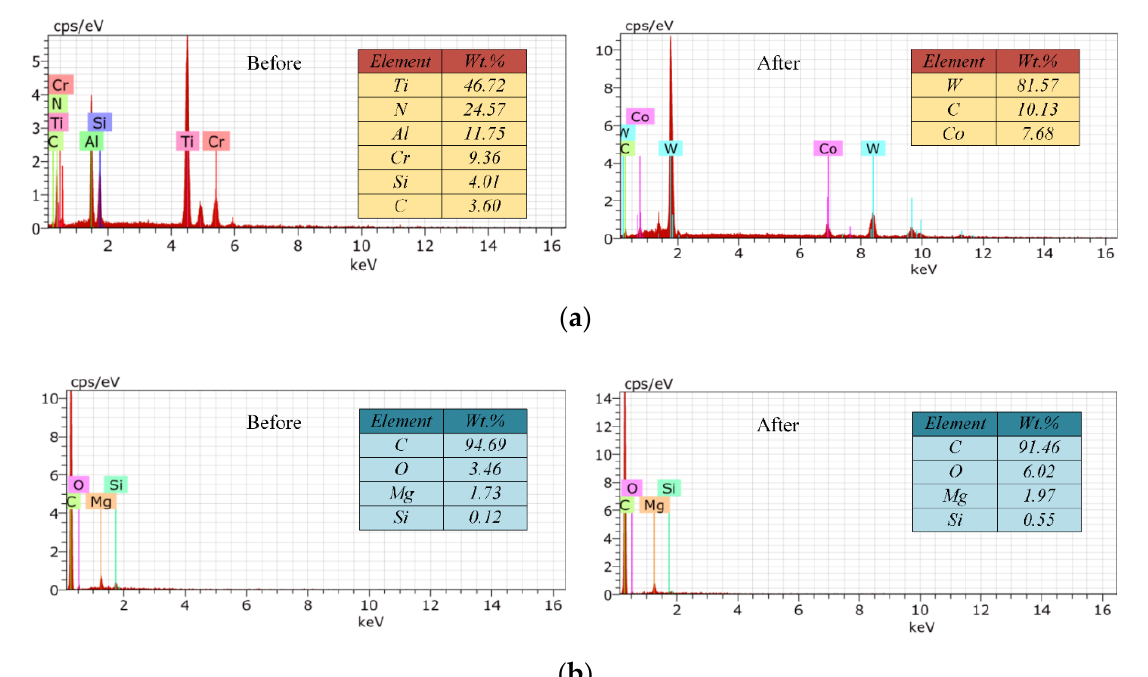
Figure 18. EDS results before and after machining a 1.0-mm-depth groove. ( a ) Carbide cutter; ( b ) Self-manufactured PCD cutter.